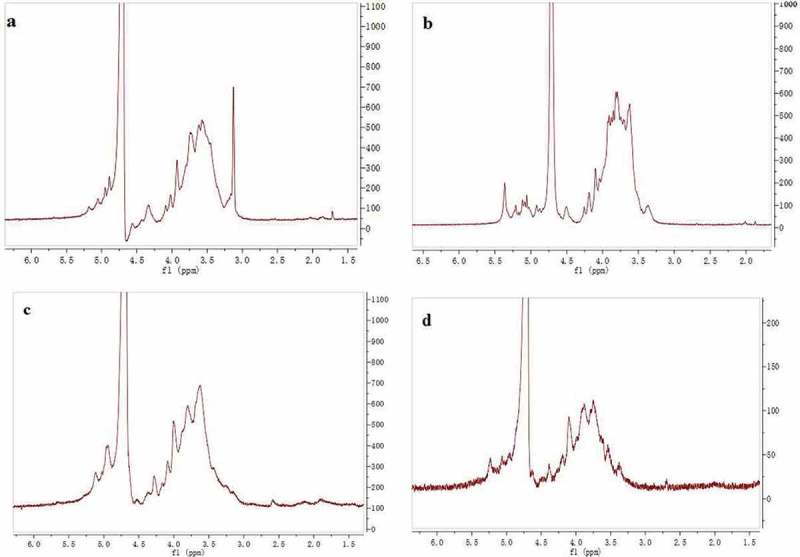

1H NMR spectrum of BSP-1a (a), BSP-1b (b), BSP-2 (c) and BSP-3 (d).